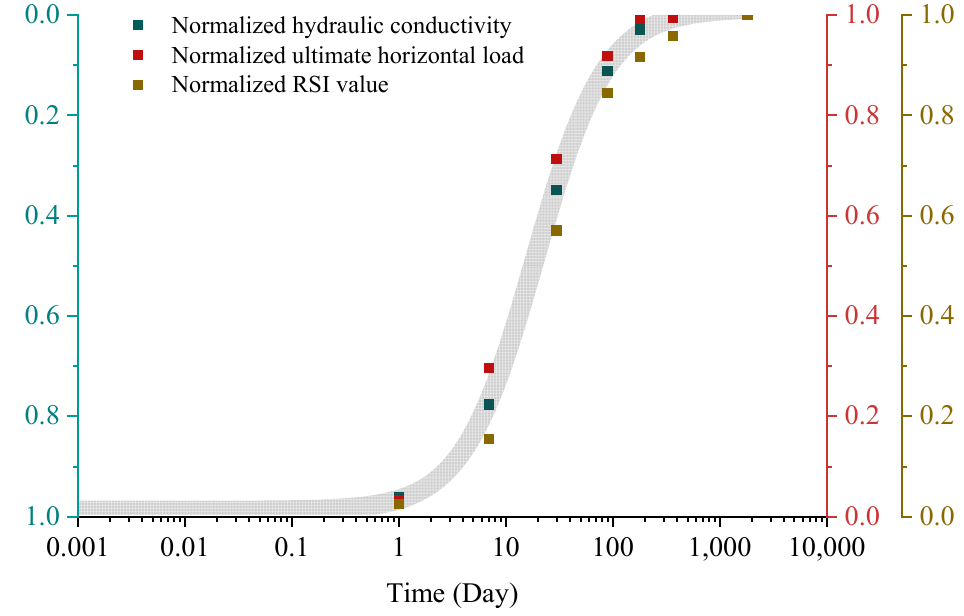
Figure 8. Normalized THM values for the reference wall.